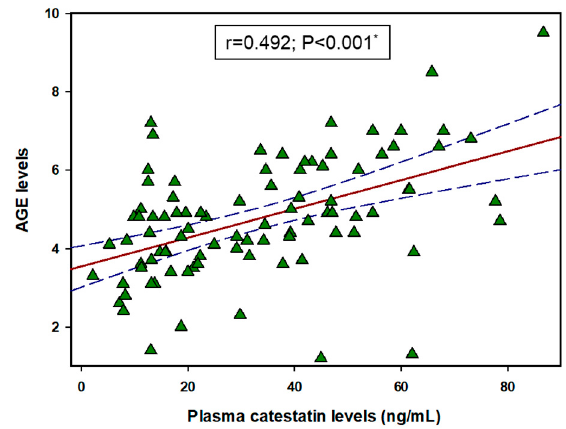
Figure 3. Correlation between CST and AGE levels in hemodialysis patients (N = 91). Abbreviations: AGE, advanced glycation end product. *, solid red line represents Pearson’s correlation coefficient, while blue lines represent 95% confidence